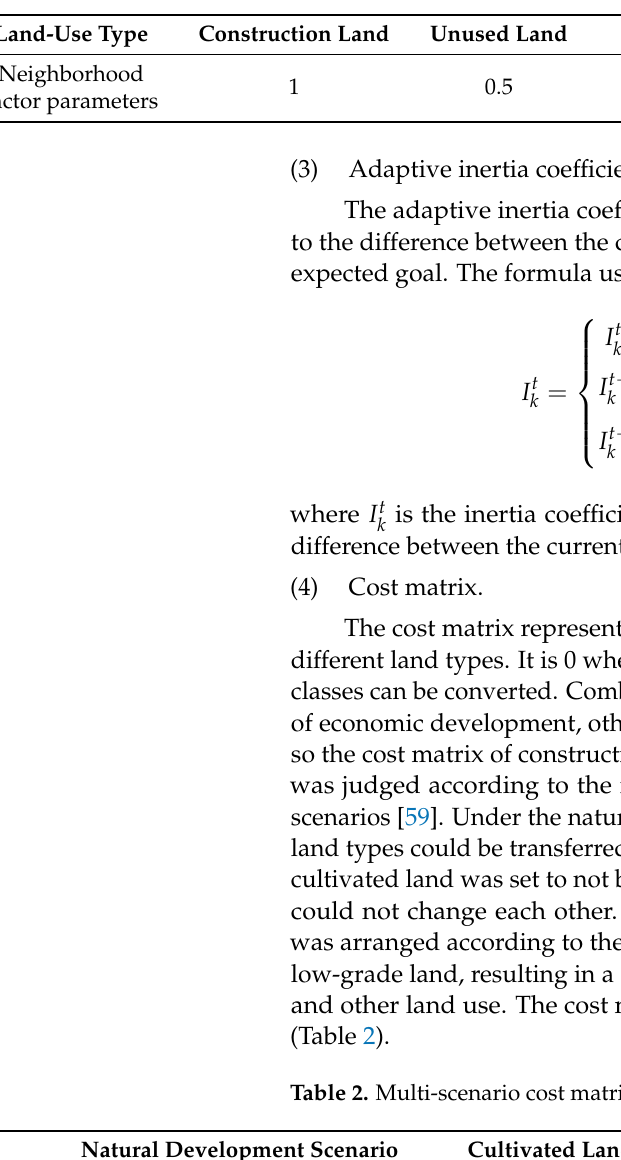
Table 1. Neighborhood factor parameters.